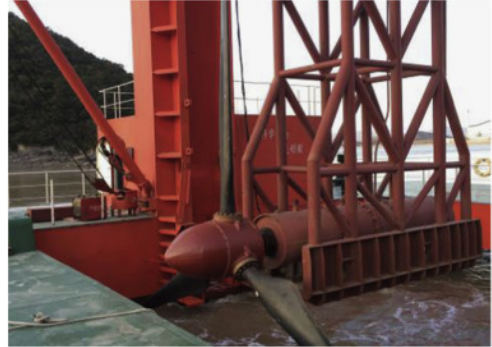
Figure 3. Small scale multibrid tidal stream turbine [15].